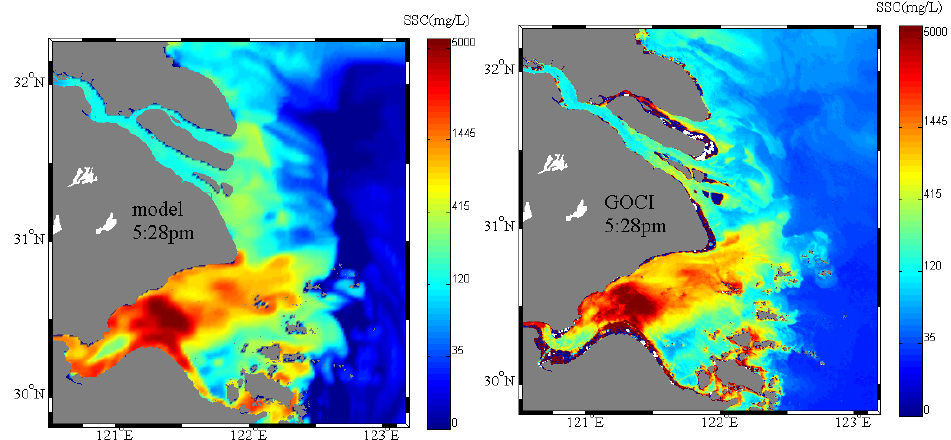
Figure 6. Comparison of simulated surface SSC with GOCI derived SSC (mg/L) on 1 January 2014.